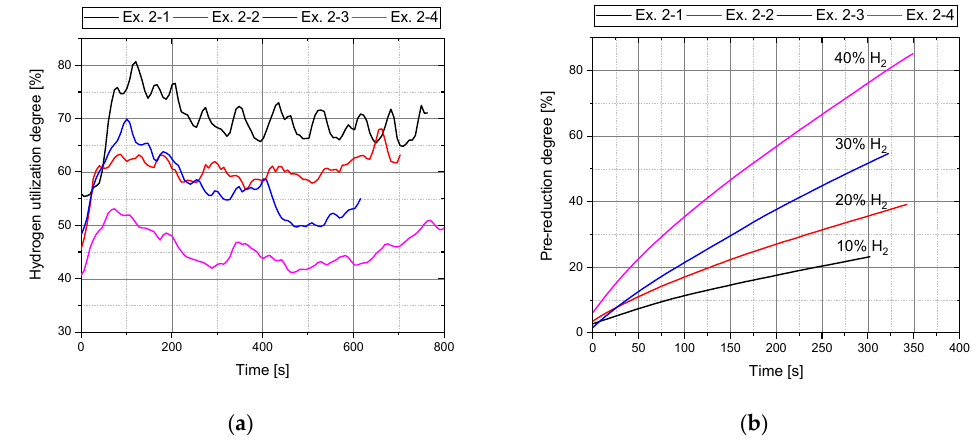
Figure 5. ( a ) Hydrogen utilization (Phase 4) and ( b ) Pre-reduction degree (Phase 3) Ex. 2–1 to Ex. 2–4.